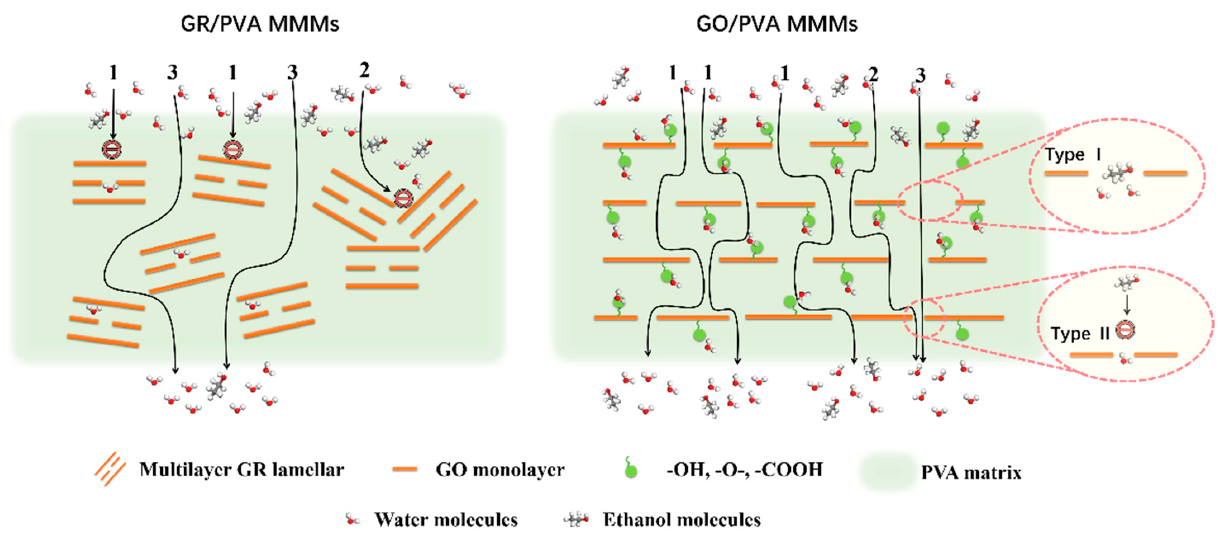
Figure 10. Schematic diagram of the hypothetic ethanol/water permeation mechanism across GR/PVA and GO/PVA MMMs.